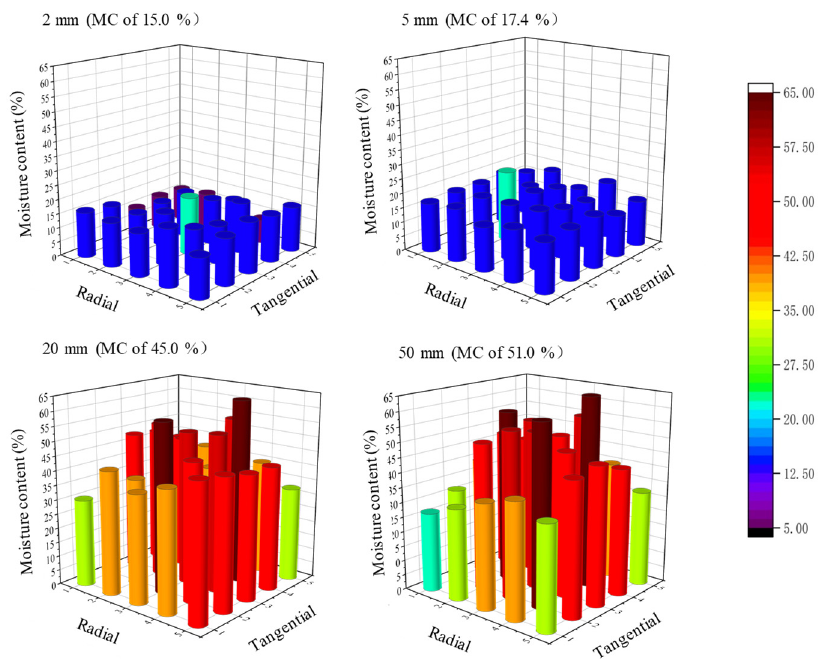
Figure 4. Three-dimensional moisture distributions of specimens with lengths of 2, 5, 20, and 50 mm after the 12th dewatering cycles.